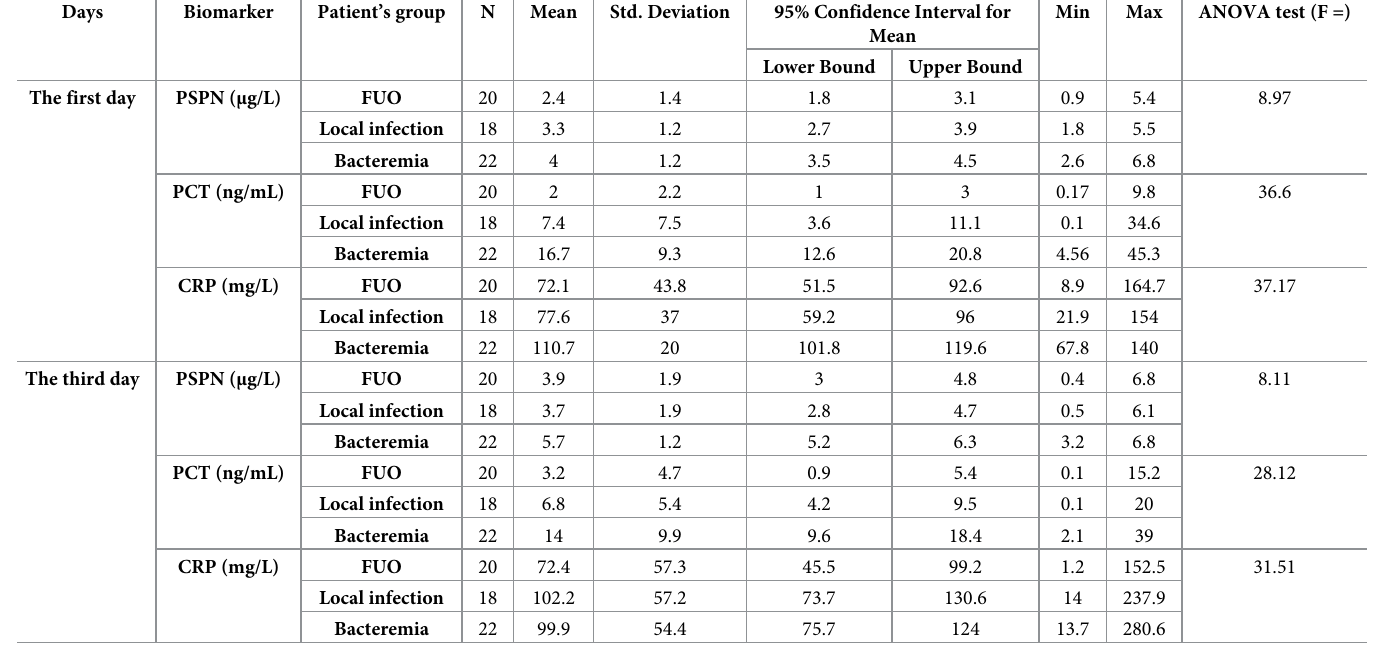
Table 2. Values of biomarkers in groups of patients according to the cause of febrile neutropenia. Days Biomarker